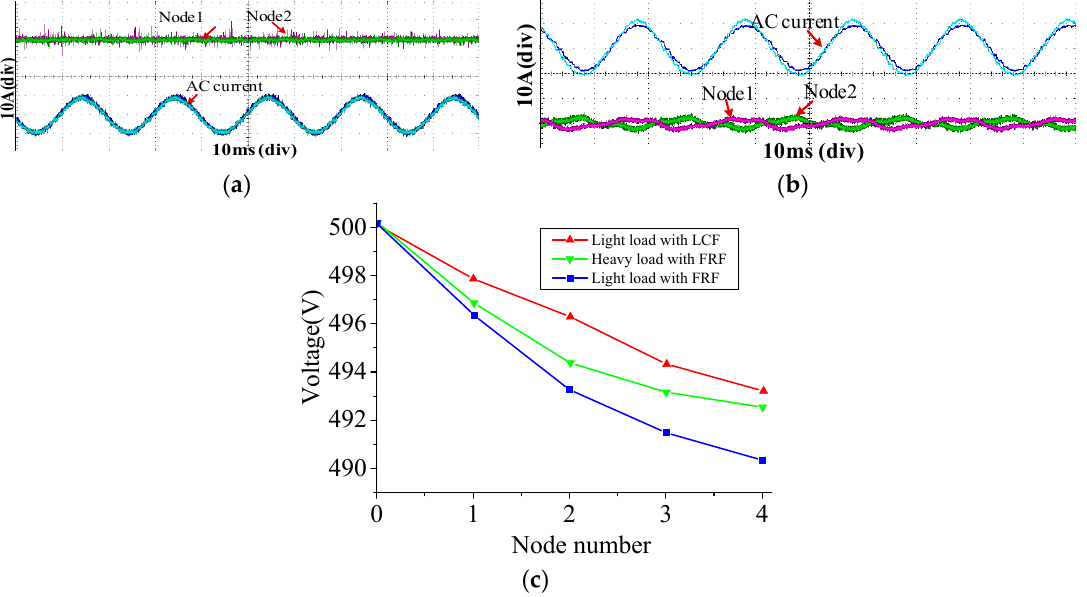
Figure 25. Filtering experiment results for high-power applications. ( a ) FRF; ( b ) LCF, and ( c ) The voltage of each node under different loads.